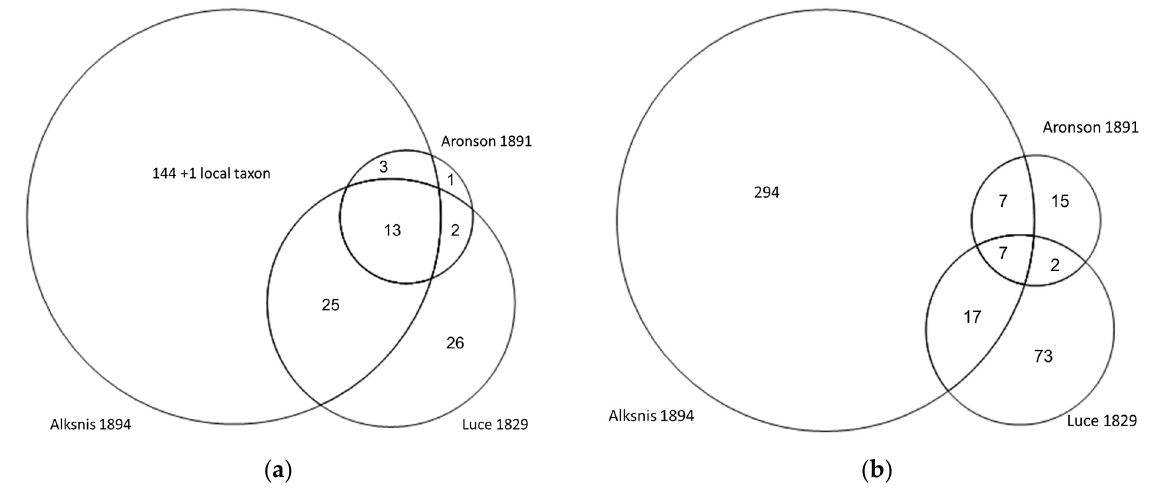
Figure 2. Proportional Venn diagrams showing the number of overlapping species ( a ) and Use Instances (UI) ( b ) among the three authors. Table 2. Comparison of the three